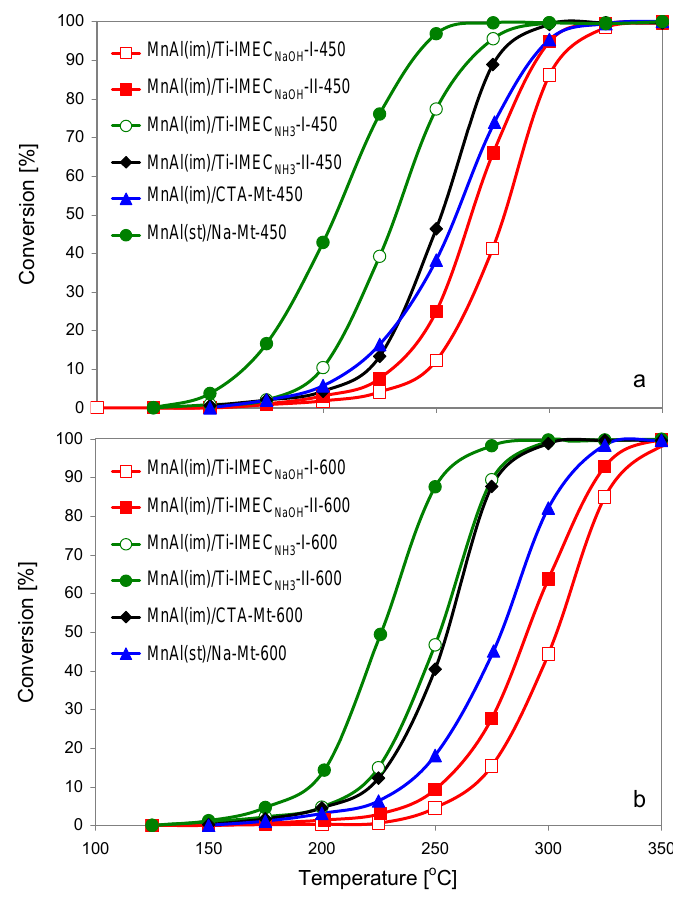
Figure 7. Ignition curves for toluene combustion over investigated composites calcined at ( a ) 450 °C; ( b ) 600 °C.